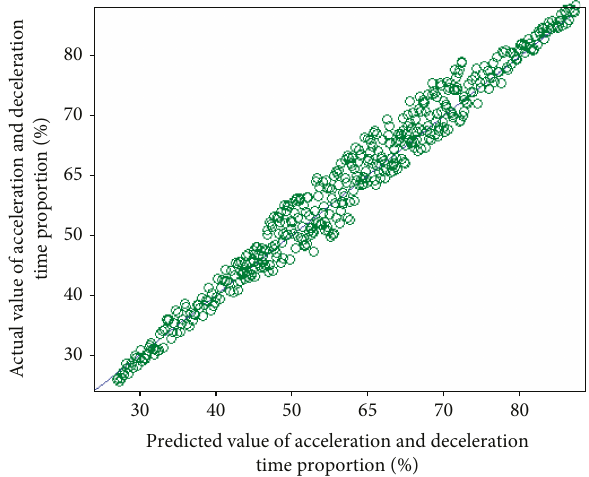
Figure 16: Scatter diagram of predicted values and actual values (uniform range proportion).